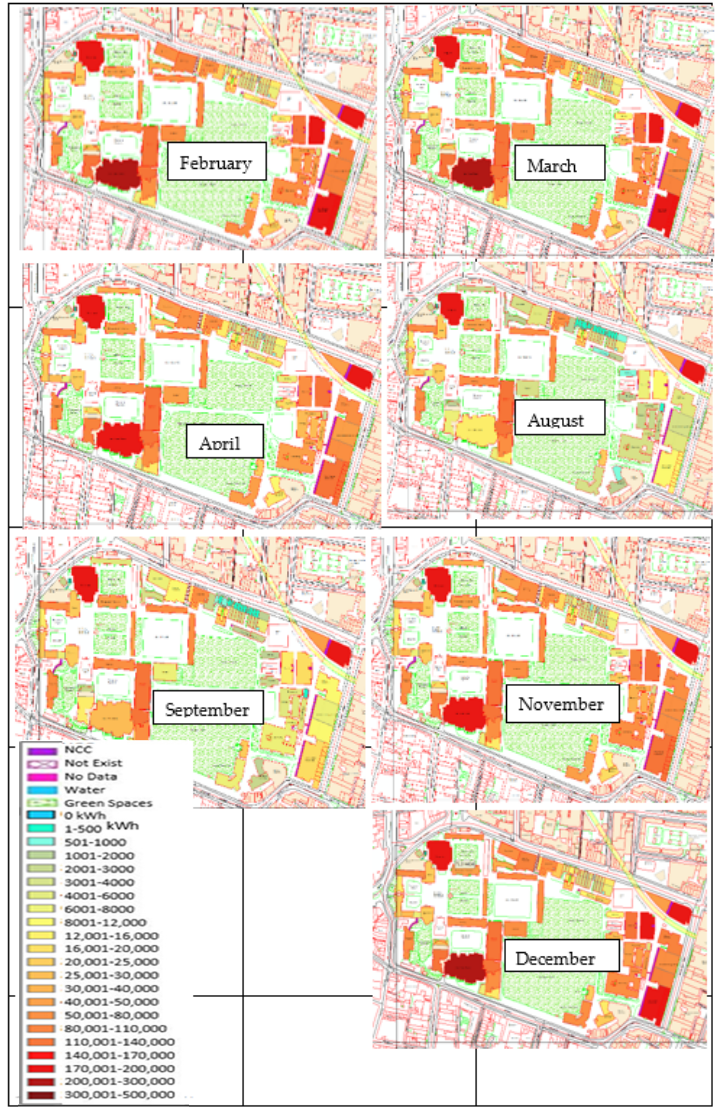
Figure 13. The monthly fossil fuel heat map of TCD in 2012.